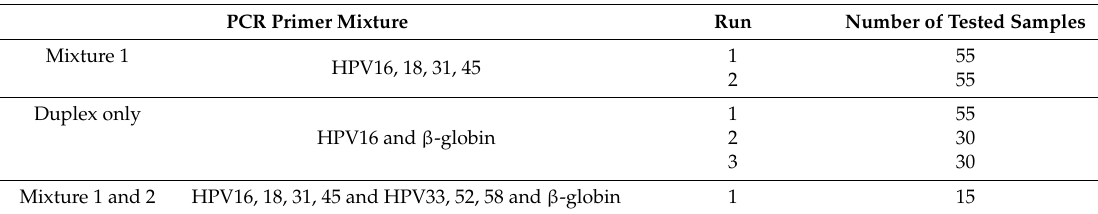
Table 3. HPV DNA detection by multiplex